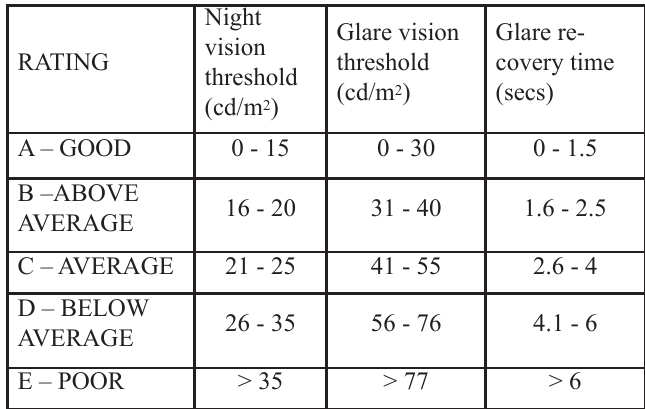
Table 1: Categorization of Night Sight Meter readings (ISO Op-